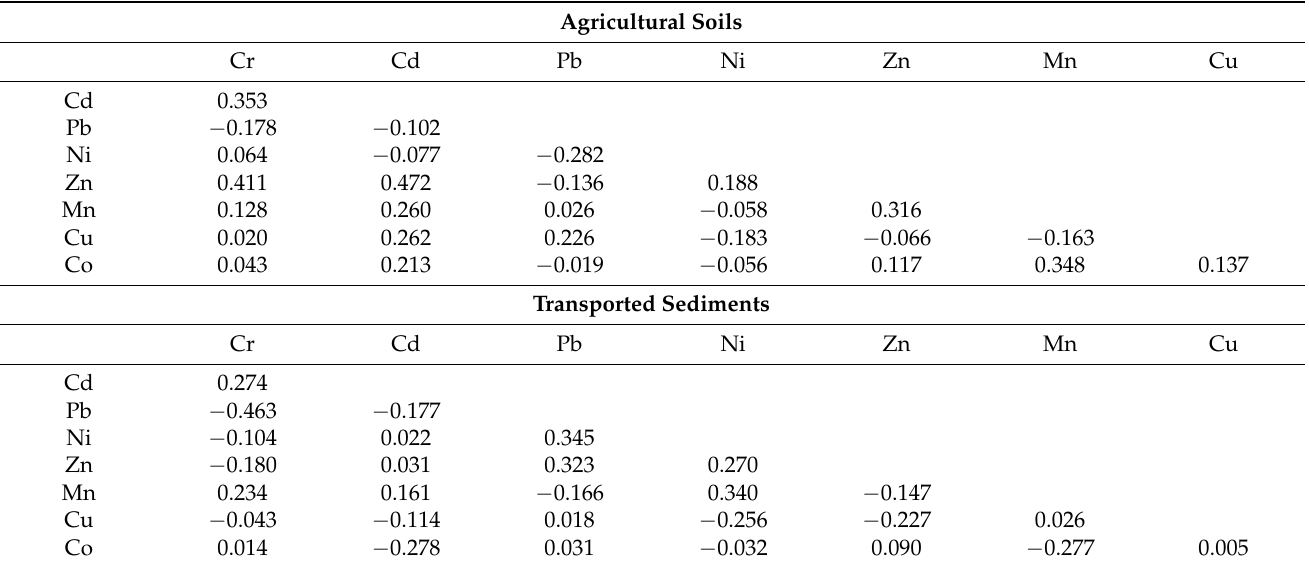
Table 5. Coefficients of correlation between every metal in agricultural soils and transported